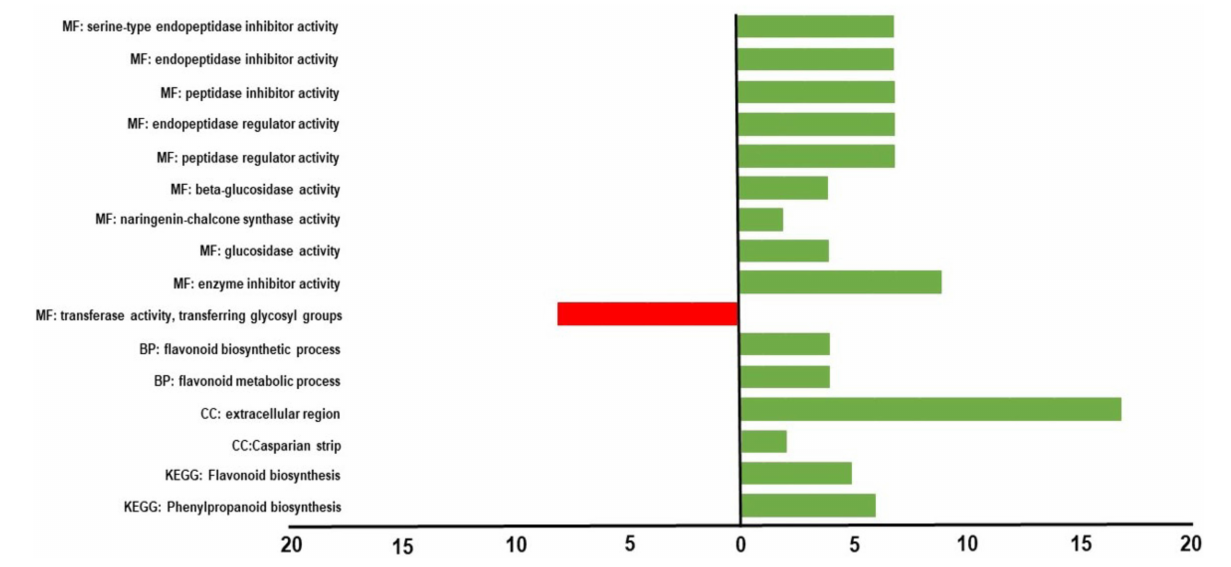
FIGURE 5 | GOs distribution of differentially expressed genes (DEGs). Gene Ontology (GO) terms associated with upregulated (green bars) and downregulated (red bars) genes in the PhAN4 HRCs compared to control HRCs, based on “Molecular Functions” (MF), “Biological Process” (BP), “Cellular Component” (CC) and KEGG ontological